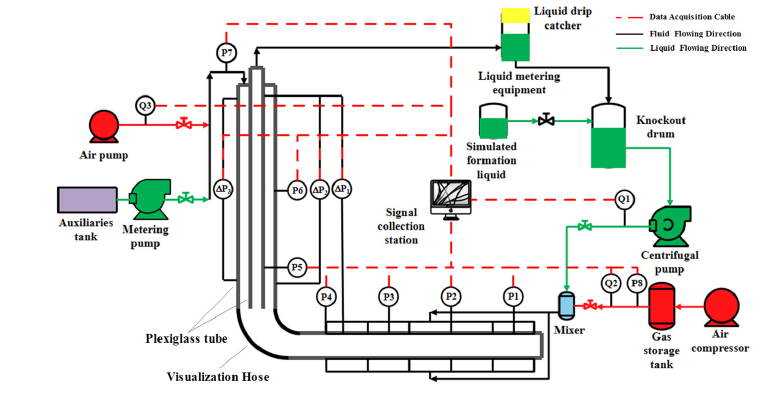
Figure 2. Schematic diagram of experimental device.